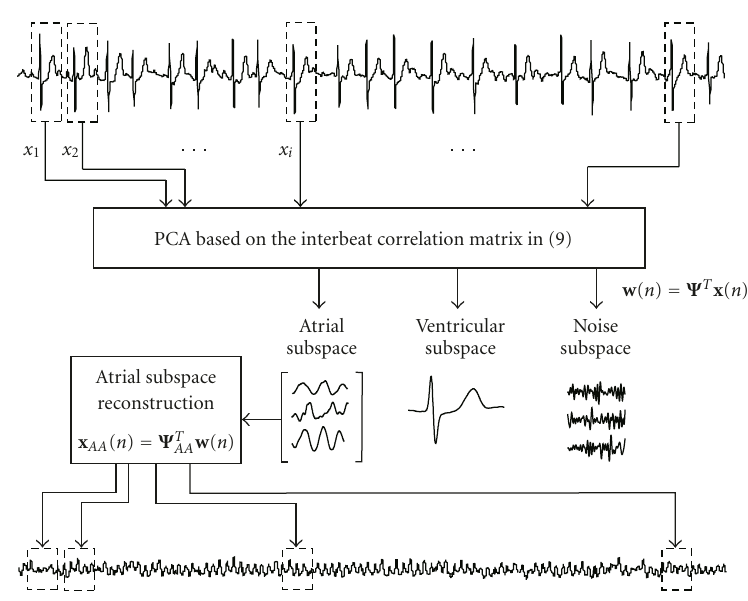
Figure 11: Block diagram of interbeat PCA to estimate the atrial activity during AF. The principal components are obtained by (10), and each of the signals in the di ff erent subspaces is given by w k ( n ). The reconstruction is made from the partitioned transformation matrix (cid:10) (cid:11) Ψ Ψ Ψ Ψ = , generating the reconstructed atrial signal x AA ( n ) using x AA ( n ) = Ψ AA w ( n ) and concatenating back to recover the atrial VA AA N signal displayed at the